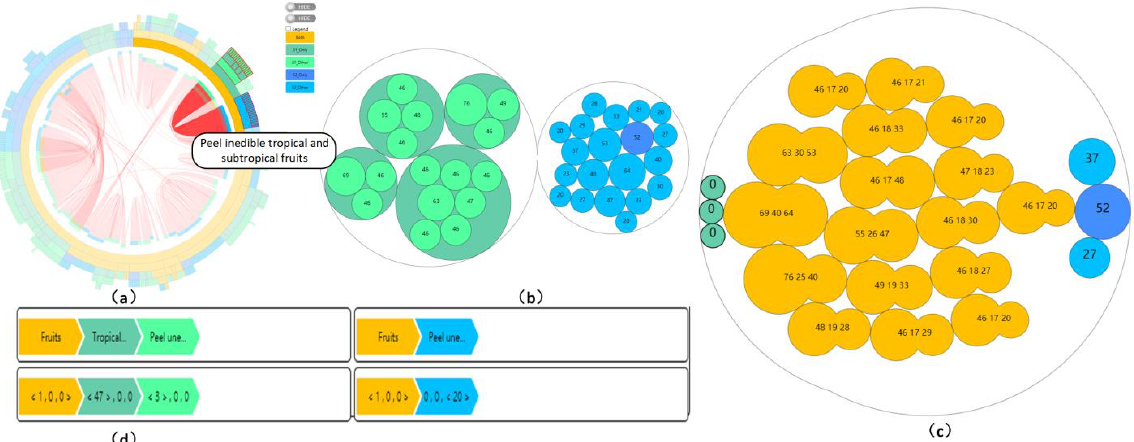
Figure 13. Exploring the classification process of “Peel inedible tropical and subtropical fruits”. ( a ) SECG shows the subtree structure of the node and the correlation between the sub-nodes. ( b ) OCT visualizes the attribute values of the node’s children. ( c ) Switch the OCT to aggregation mode. ( d ) The process of passing and accumulating the leaf nodes according to the path